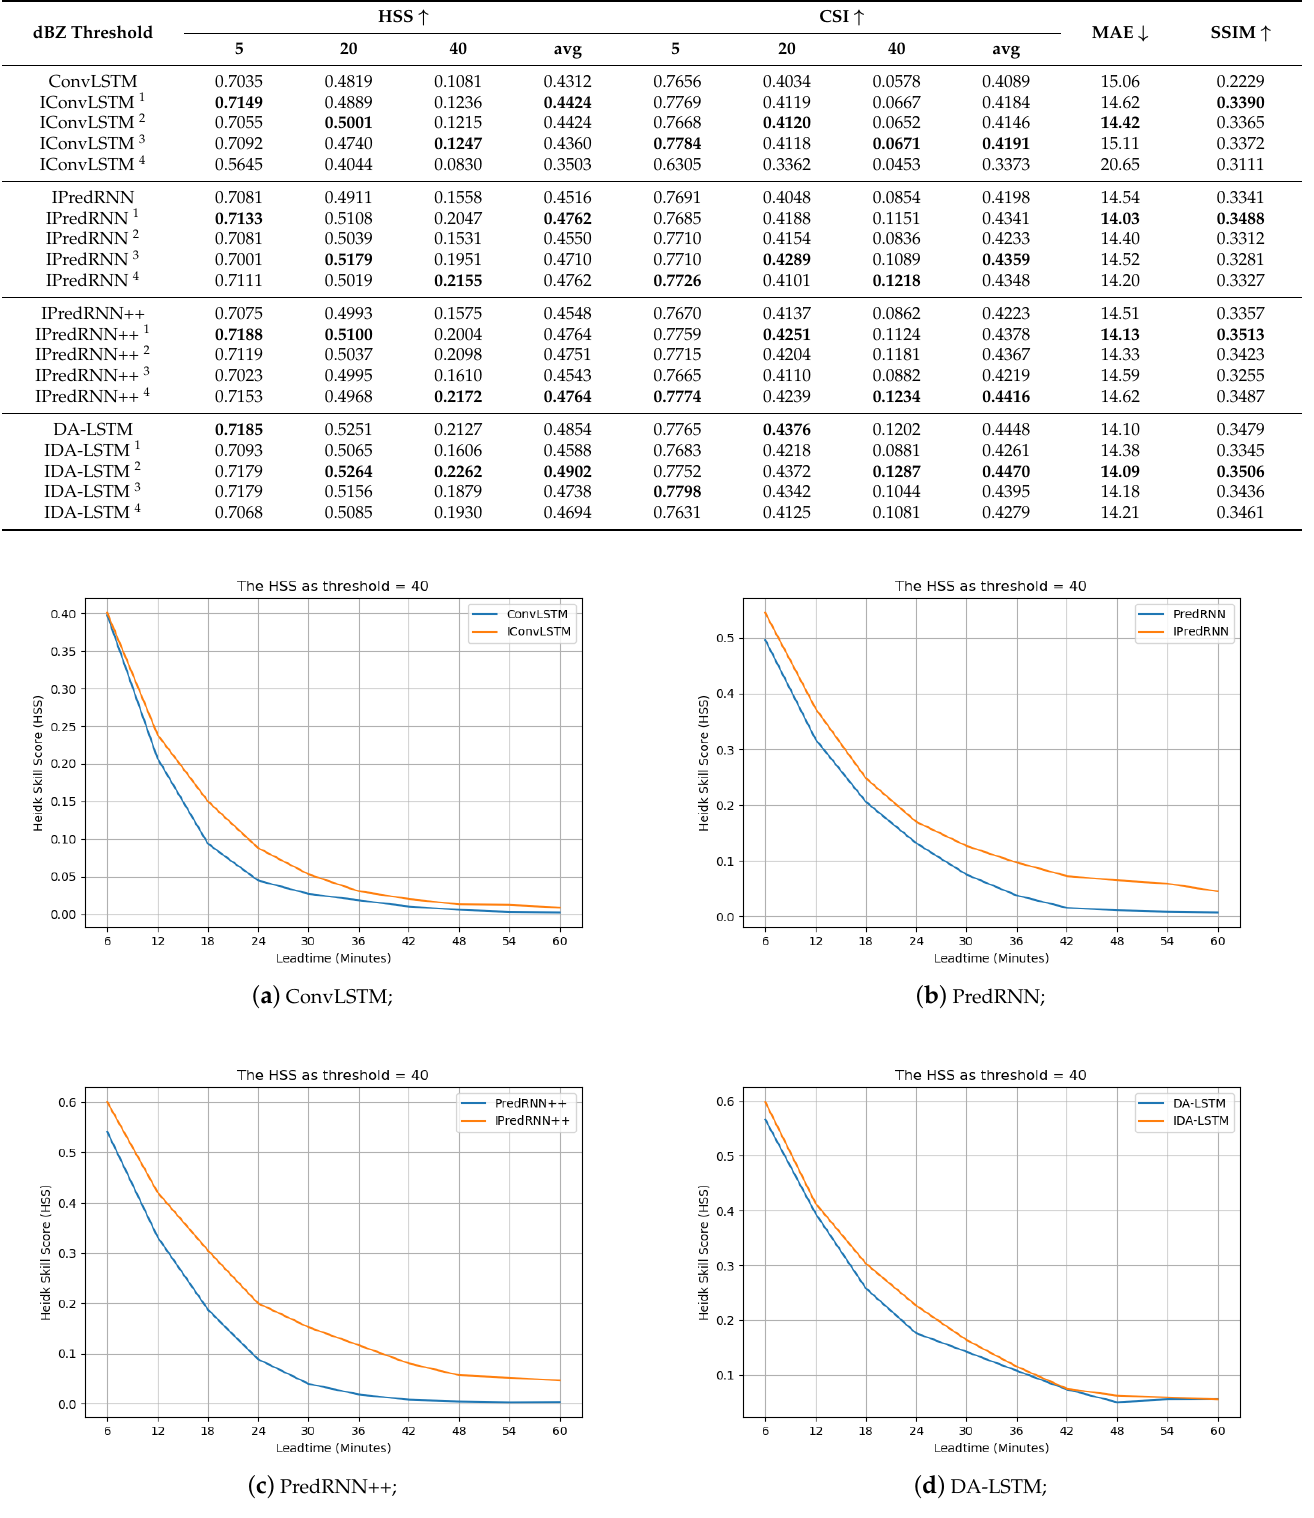
Figure 12. The performance changes against different nowcast lead times in interaction ablation study in terms of HSS as the threshold is 40 dBZ. (Best view in